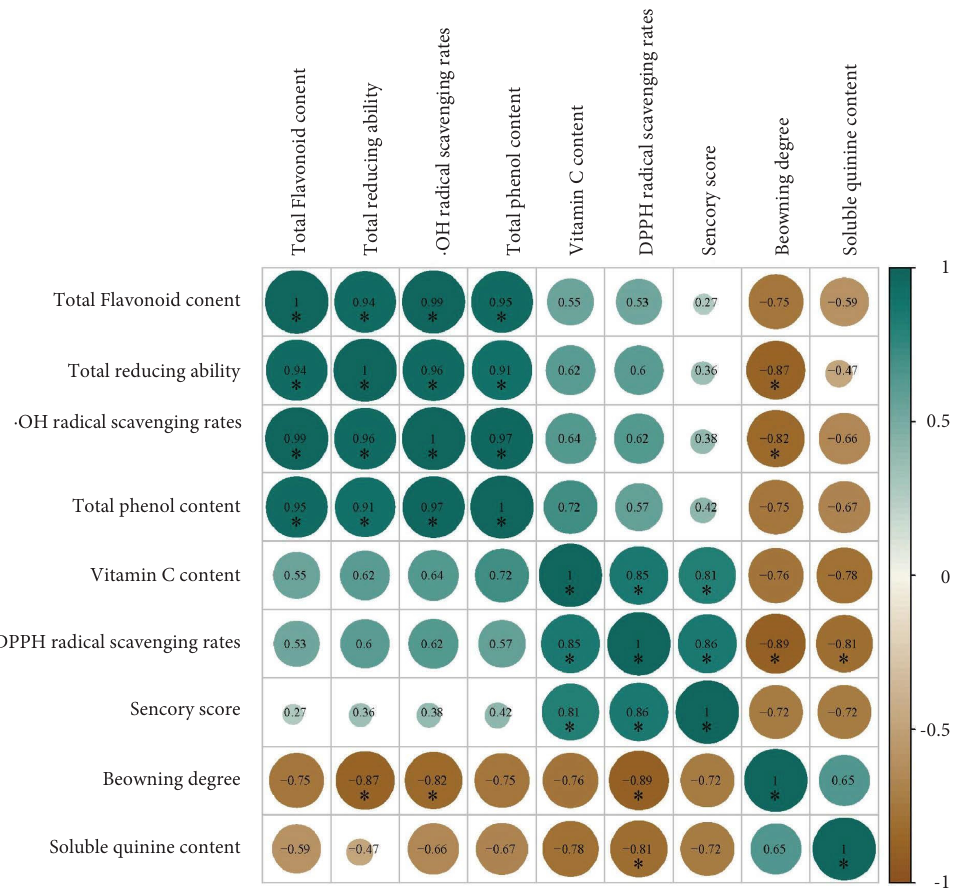
Figure 7: Pearson correlation analysis of various indexes under traditional heating and vacuum concentration temperatures. ∗ indicated signifcant correlation ( p < 0 .